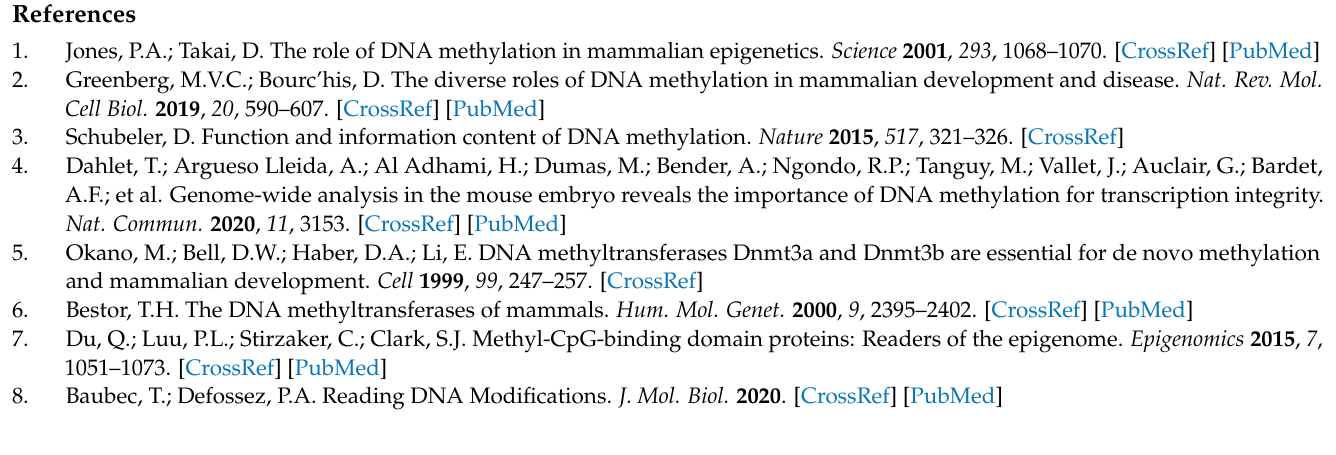
according to their DNA methylation profiles. Figure S2: New patients enrolled in the study. Figure S3: Analysis of the genomic context of reduced DNAme in patients. Figure S4: Gene Ontology of genes linked to DMPs in a given disease. Figure S5: DNA methylation status of DNA repeats in each patient. Figure S6: DNA methylation status of satellite DNA repeats in each patient. Figure S7: DNA methylation landscapes at developmentally regulated clusters of genes in disease groups. Figure S8: DNA methylation landscapes at HOX genes clusters in disease groups. Figure S9: Hypomethylated sites specific or shared between patient groups. Figure S10: (Epi)genomic annotation of HypoMPs in patients with mutations in DNMT3 catalytic or non-catalytic domains. Figure S11: Genomic annotation of HypoMPs shared between patients with NSD1 or DNMT3 mutations. Tables S1